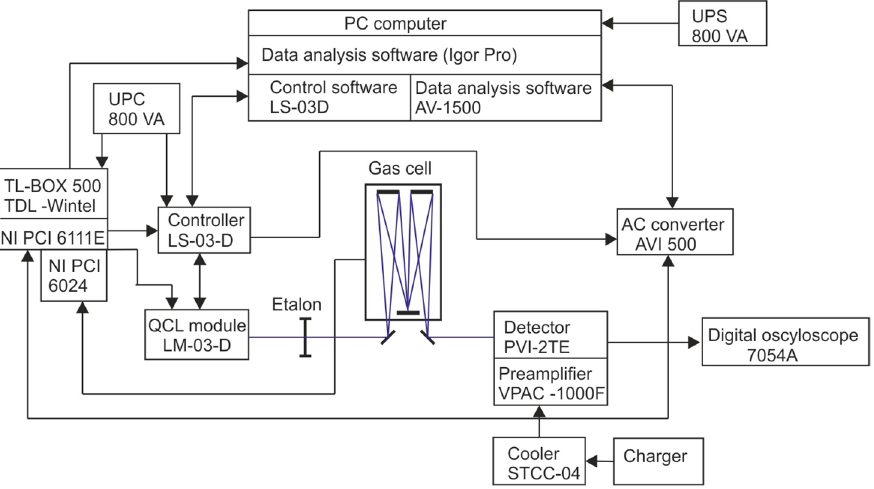
Figure 8. Diagram of the analyzer, view of the LS-03-D controller and the LM-03-D laser module. An example of the atmospheric spectrum measured with a cascade laser is shown in Figure 9.